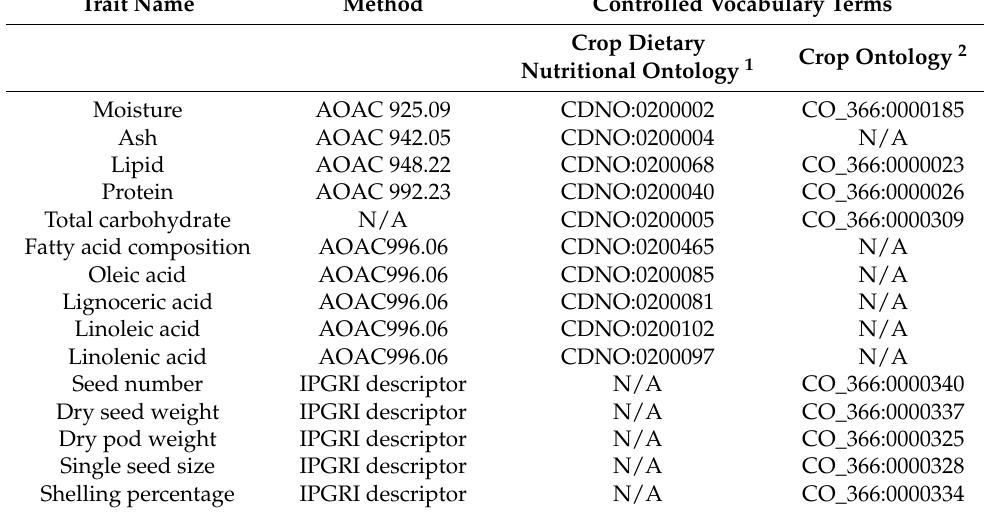
Table 3. List of seed composition and agronomic traits used in this study with equivalent con- trolled vocabularies in the Crop Dietary Nutritional Ontology (CDNOhttp://www.obofoundry.org/ ontology/cdno.html, accessed on 13 December 2021) [51] and the bambara groundnut Crop Ontol- ogy (CO_366; https://cropontology.org/term/CO_366:ROOT, accessed on 13 December 2021) [52]. N/A = Not available. Trait Name Method Controlled Vocabulary Terms Crop Dietary Crop Ontology 2 Nutritional Ontology 1 Moisture AOAC 925.09